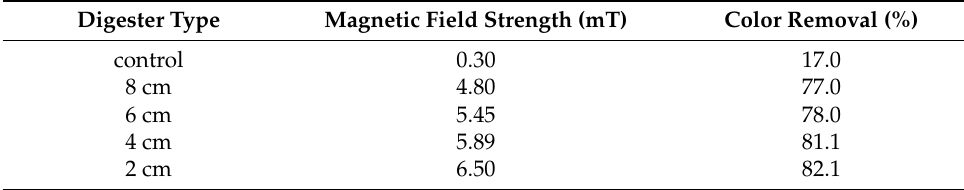
Table 2. Influence of magnetic field strength on color removal.